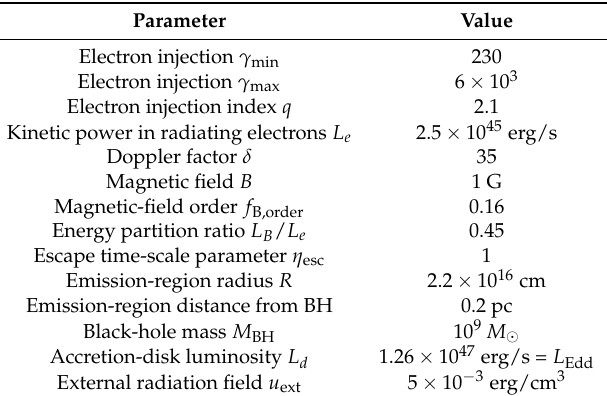
Figure 3. Left panel: Contemporaneous optical + γ -ray spectral energy distribution (SED; red) of 4C+01.02, along with archival data (from NED 3 ; blue), and our SED model (solid red). Right panel: Top: Optical spectrum with the 3 LCO photometry points, with our model (red lines). Bottom: SALT spectropolarimetry (data points), along with our model prediction (solid red line), and the degree of polarization of the synchrotron radiation component (red dotted). Table 1. Model parameters. BH: black